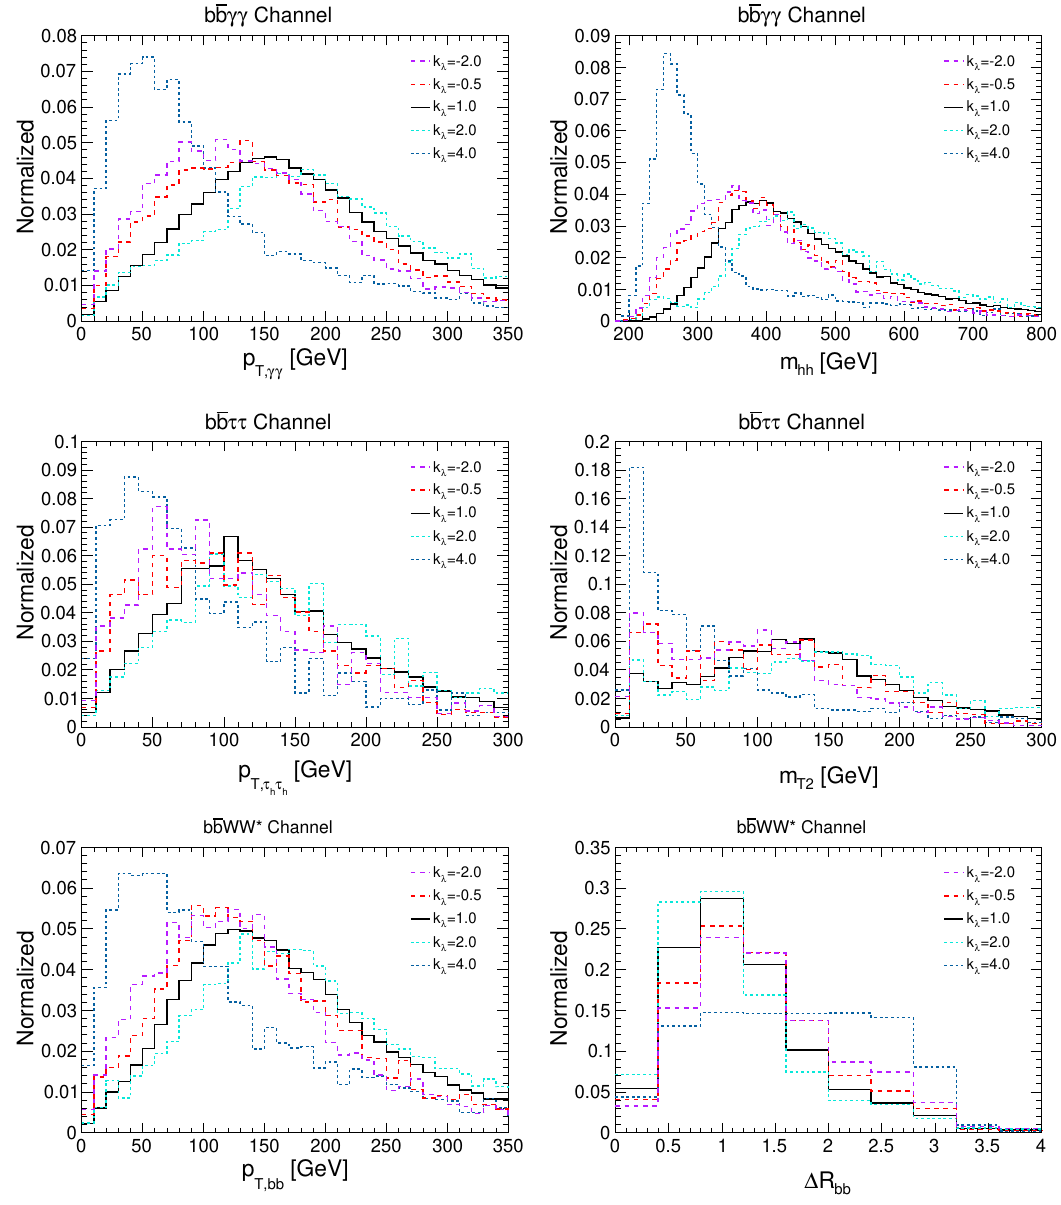
Figure 17 . Normalized distribution of (a) p T,γγ and m hh in the b ¯ bγγ channel (top), (b) p T,τ and m T 2 in the b ¯ bττ channel (middle), (c) p T,bb and ∆ R bb in the b ¯ bWW ∗ channel (bottom), for different values of k λ = λ/λ SM